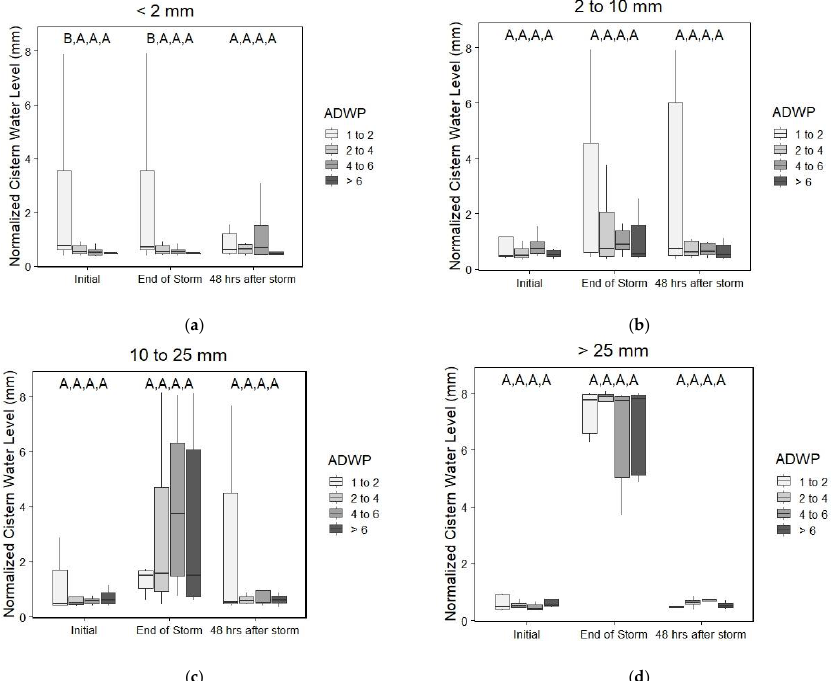
Figure 2. Normalized cistern water level for different storm sizes ( a – d ) and antecedent dry-weather periods (ADWPs) (days). Normalized cistern water level denotes the water volume normalized per green-roof area. The letters at the top denote statistical significance—two groups that share a letter were not statistically different from one another ( p > 0.05). Here, A denotes statistically equivalent results, while B denotes statistically different results.